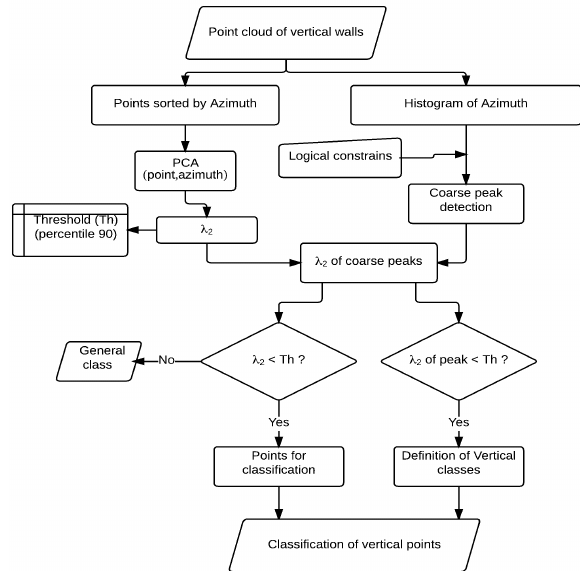
Figure 2. UML diagram of the heuristic process for the segmentation of points that belong to vertical walls.